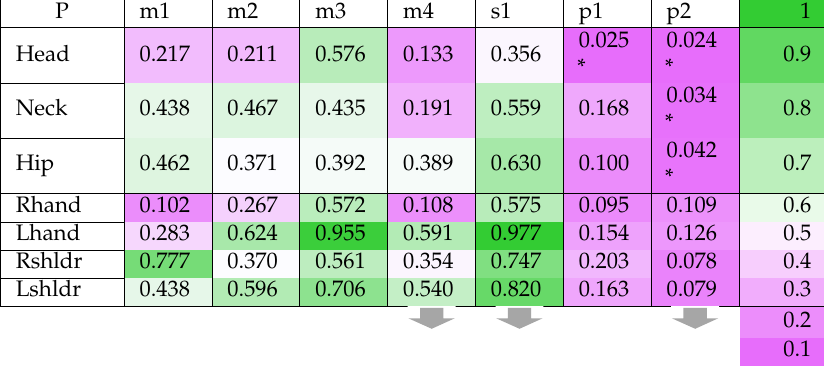
Table 1. Linear regression probability of each targeted joint motion per scene with MMSE score.